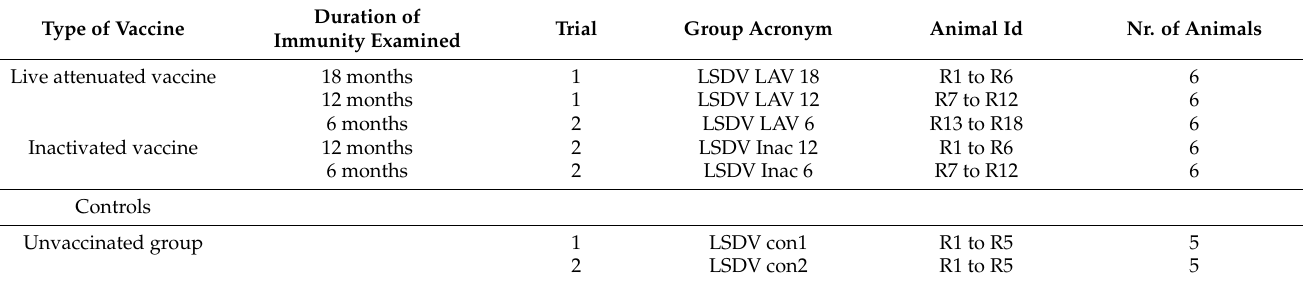
Table 1. Overview experimental setup. Duration of immunity is considered as the time between the last vaccination and the moment of